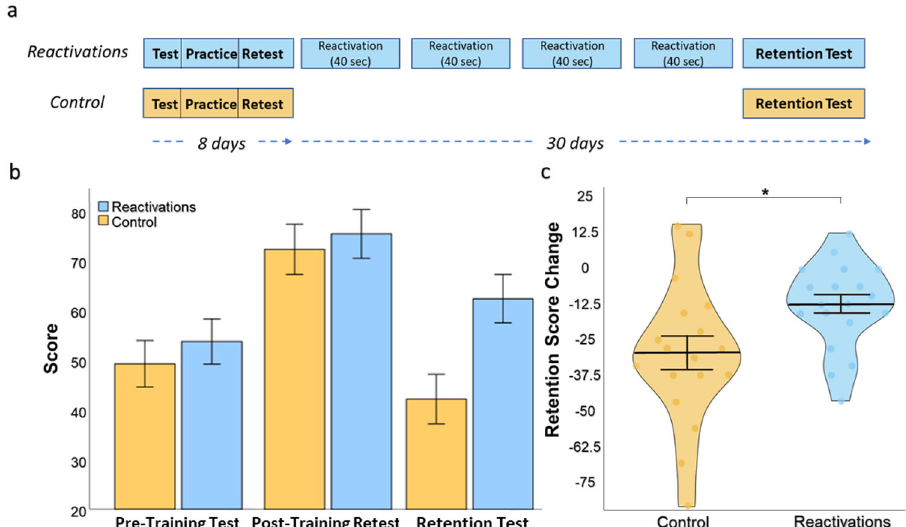
Fig. 3 Long-term retention. a Experimental design. Participants fi rst completed an 8-day standard practice procedure and were tested for retention following 30 days. Participants were divided into 2 groups: Reactivations which completed 40-second reactivation sessions once per week between post-training retest and retention test, and Controls without reactivations. b Mean scores per session for each group. c Violin graph showing the mean score change from post-training retest to retention. Each point re fl ects a participant. * P < 0.02. Error bars represent standard error of the